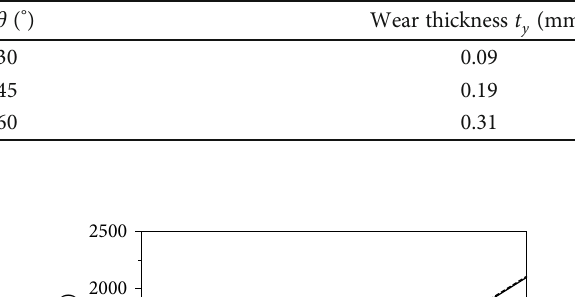
Figure 28: Unlocking force corresponding to di ff erent Φ = 0 : 05 , θ = 45 ° , and Φ